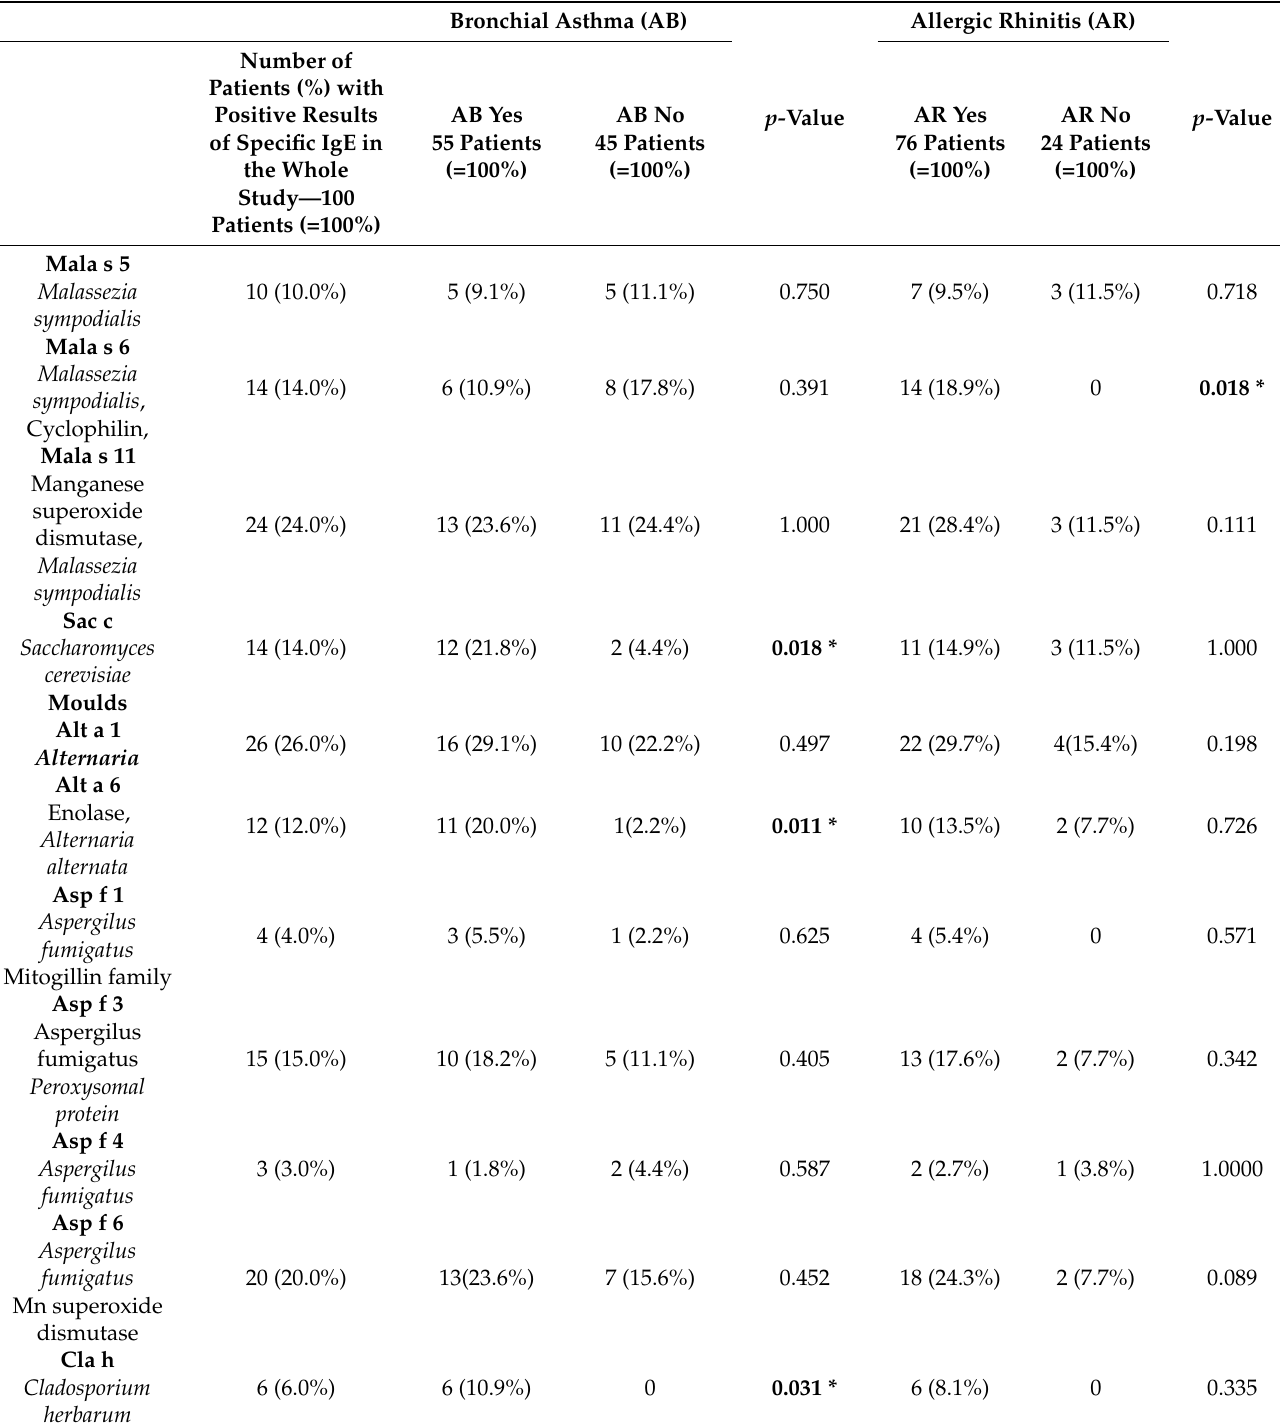
Table 5. The sensitization rate to molecular components of yeast and molds in 100 atopic dermatitis patients. We show the number of positive results in the whole group of patients and in patients with bronchial asthma (AB) and allergic rhinitis (AR), the relative frequency of sensitization rate is recorded in %. The significance level was set to 5%. The significant difference ( p -value < 0.05) in the sensitization rate is shown extra bold *, (the statistical analysis is made with Fisher´s exact